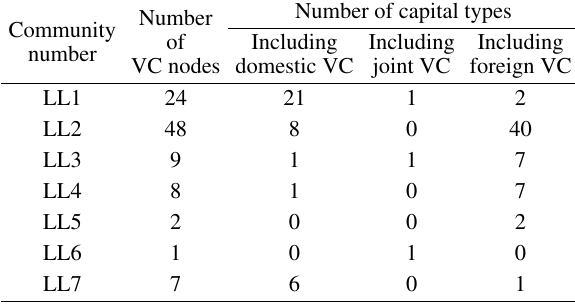
Table 6 Association of communities and capital types in